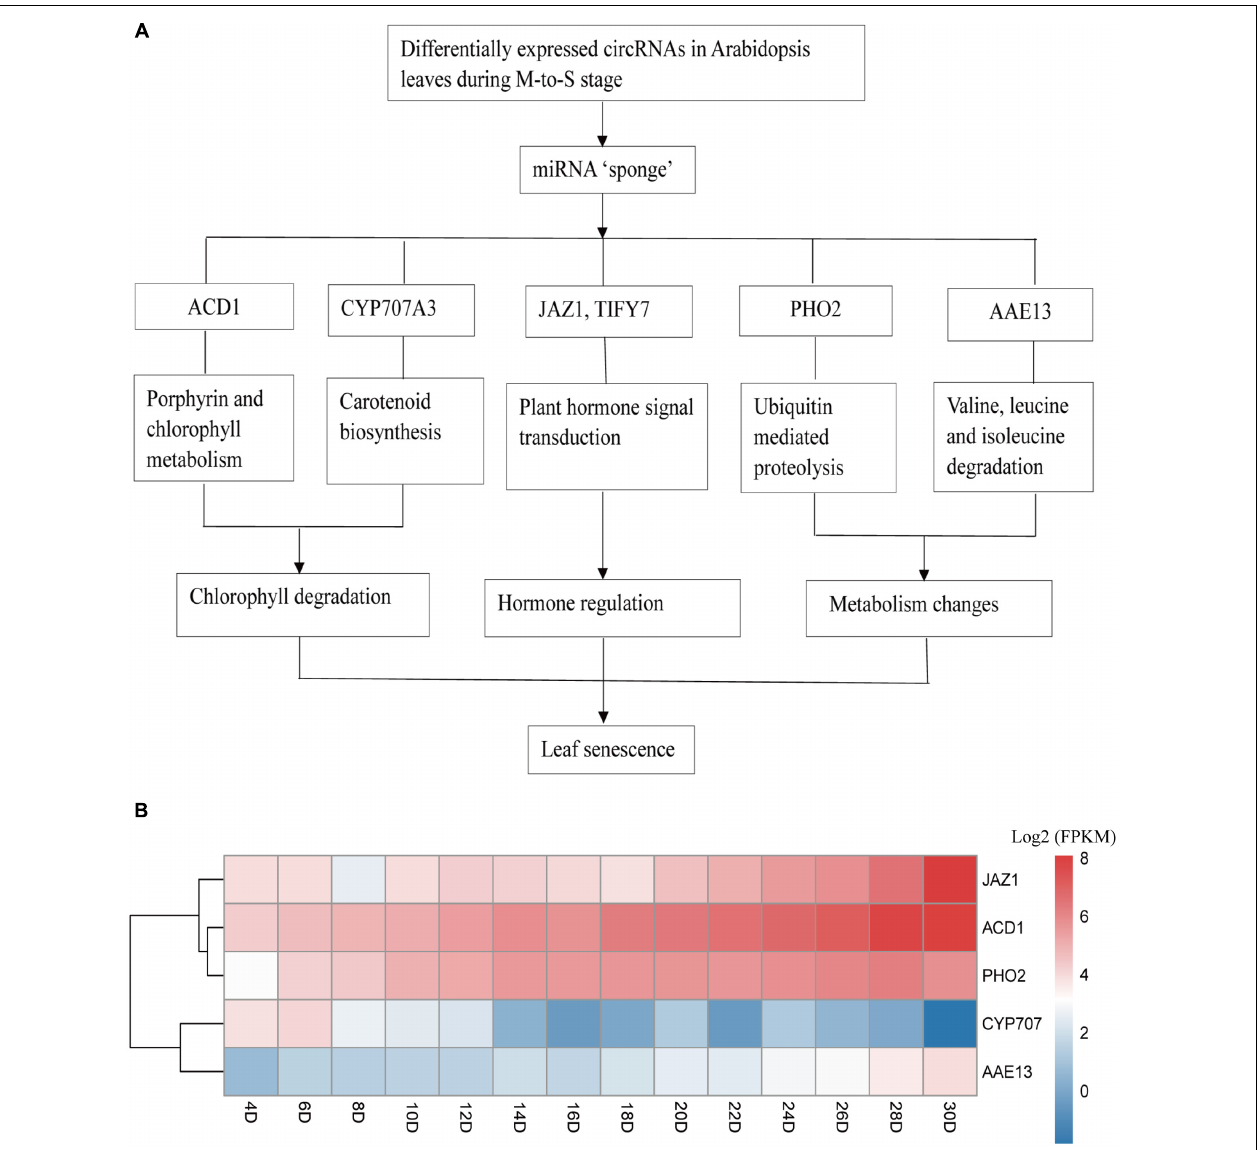
FIGURE 5 | Possible regulatory mechanism involving differentially expressed circRNAs and their target genes in Arabidopsis leaves at M- to -S stage. (A) ACD1, Pheophorbide a oxygenase family protein with Rieske 2Fe-2S domain-containing protein; CYP707A3, cytochrome P450, family 707, subfamily A, polypeptide; JAZ1, jasmonate-zim-domain protein 1; TIFY7, TIFY domain/Divergent CCT motif family protein; PHO2, phosphate 2; AAE13, AMP-dependent synthetase and ligase family protein. (B) The expression profile of five target genes during the lifespan of Arabidopsis